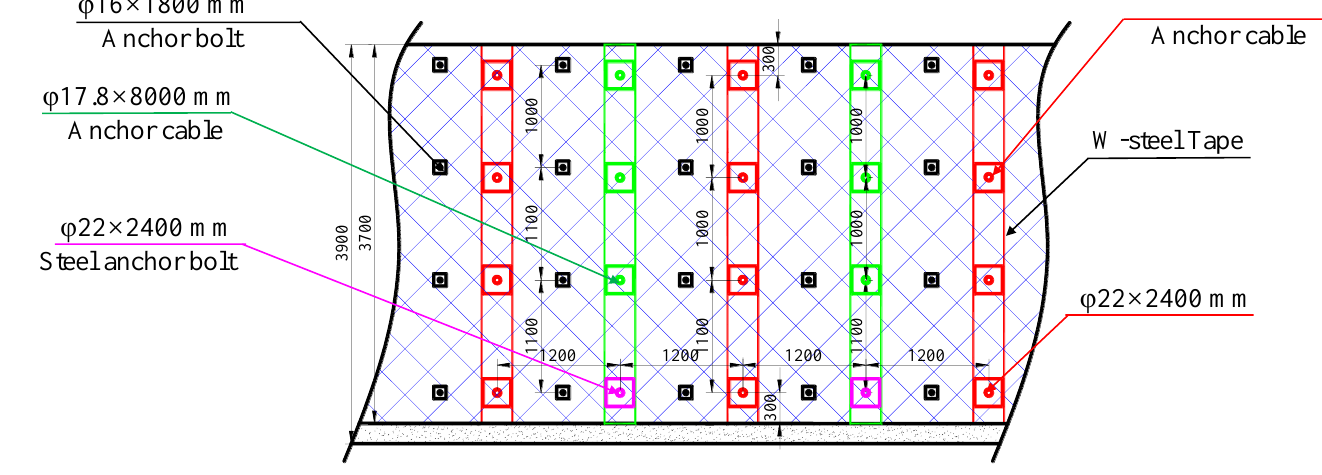
Figure 15. Secondary reinforcement and support of auxiliary wall of main retracement roadway.